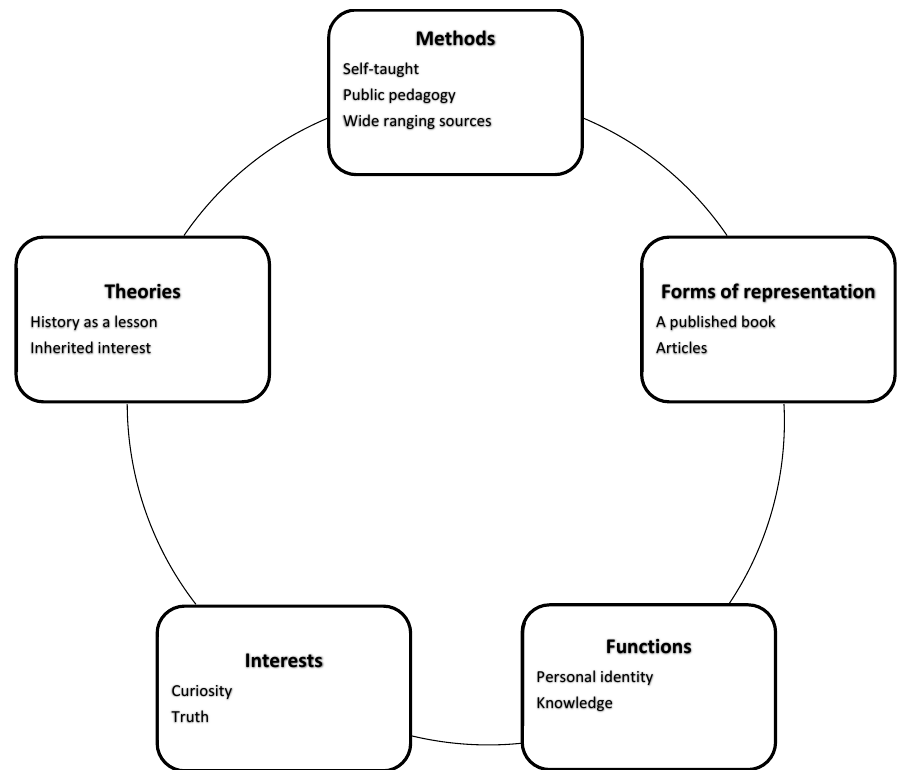
Figure 5. Case study four in alignment with Rüsen’s (1993) Disciplinary Matrix.